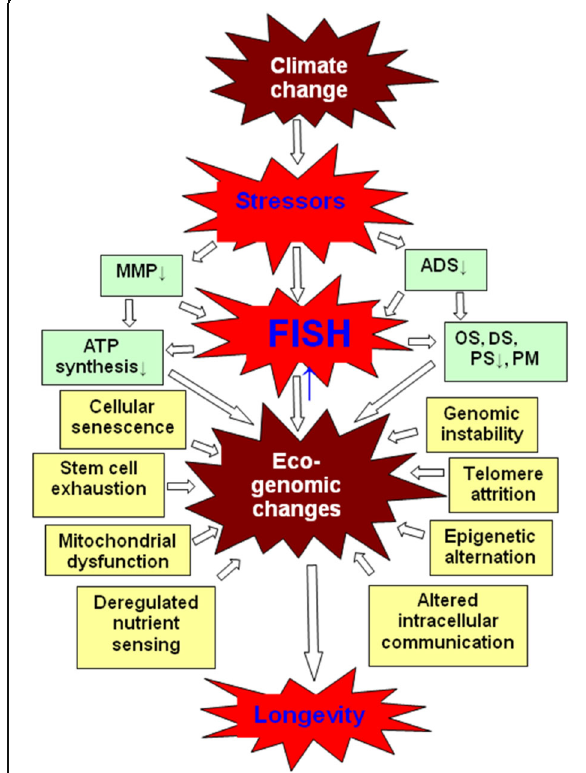
Fig. 2 Possible correlation between climate change and epigenomics in aquatic animals, for example fish, modulated by metabolism. Climate change is responsible to increase the mean global temperature which may lead to produce many unwanted metabolites such as reactive oxygen species (ROS) in susceptible aquatic animals, for example fish. Increase in single or multiple stressors such as pollutants, temperature, and salinity can also be responsible to produce ROS